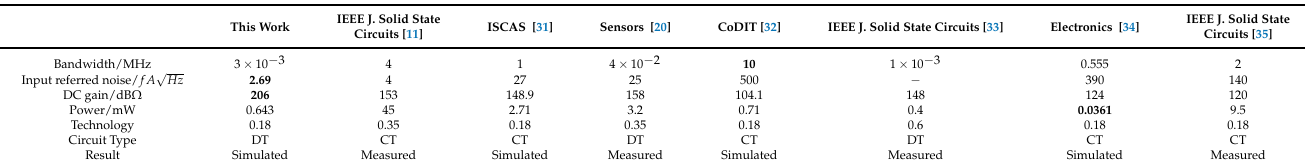
Table 1. The comparison result of the performance of circuits. CT represents continuous type, DT represents discrete